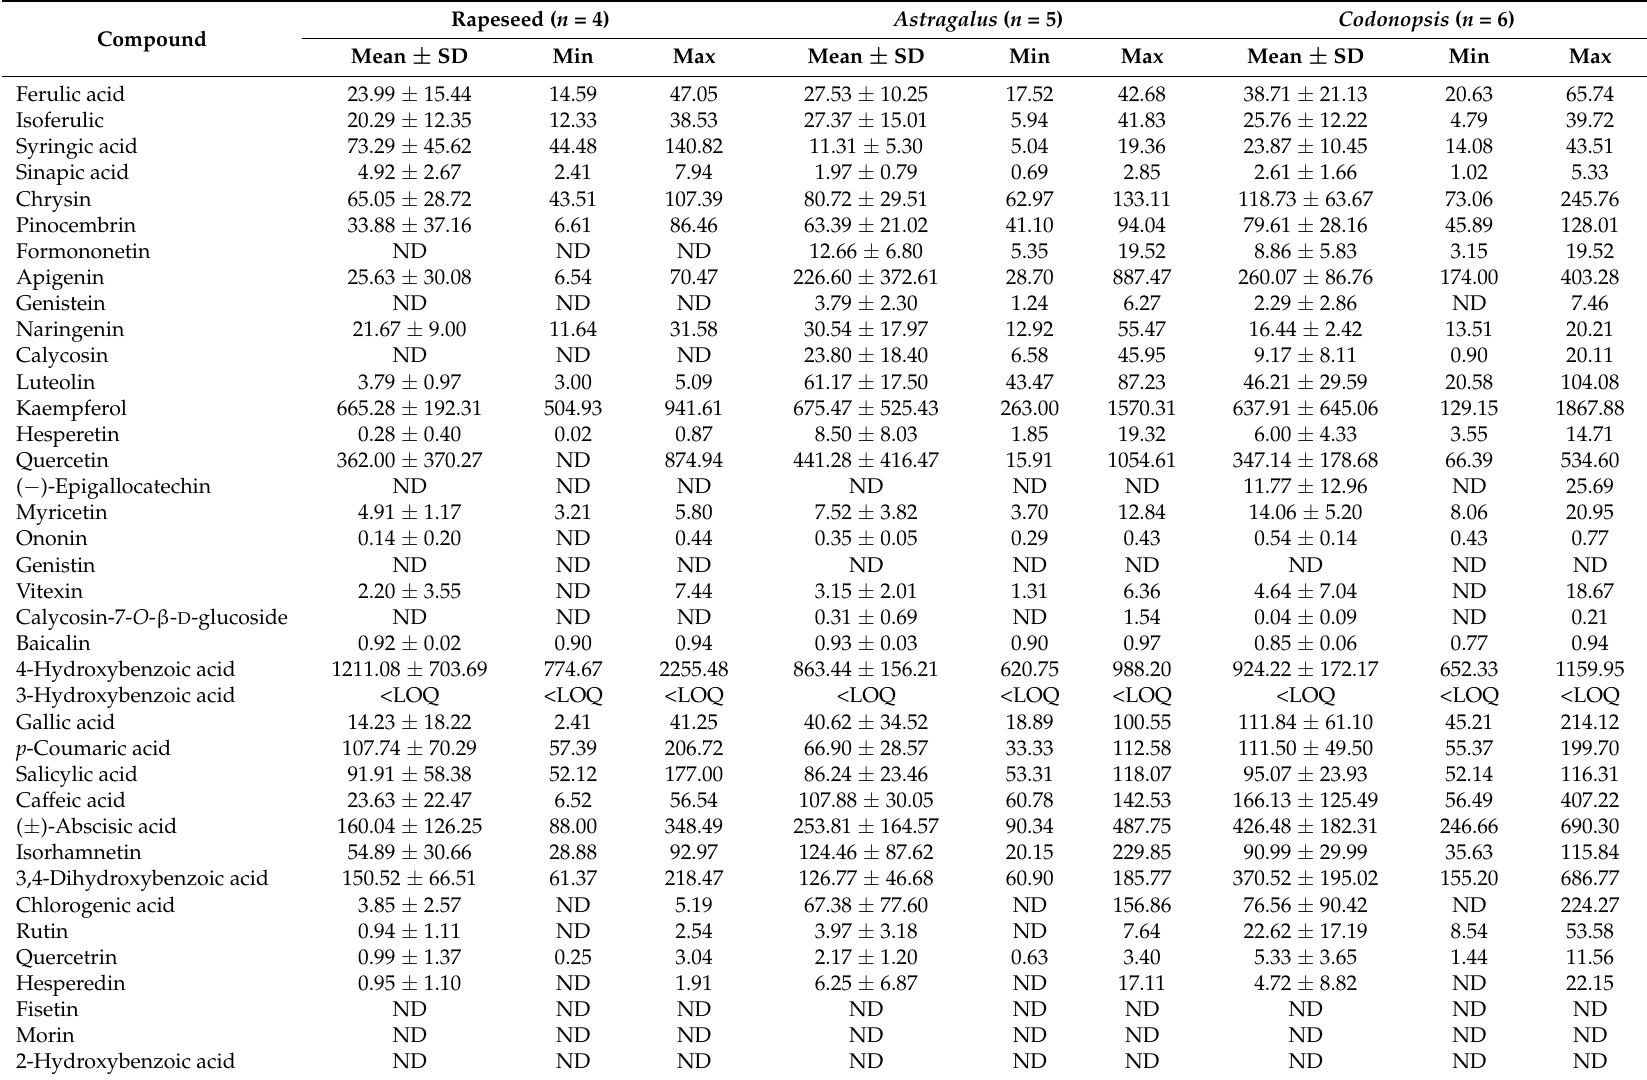
Table 4. Content of phenolic and flavonoid compounds in rapeseed, Astragalus and Codonopsis honey samples (ng g − 1